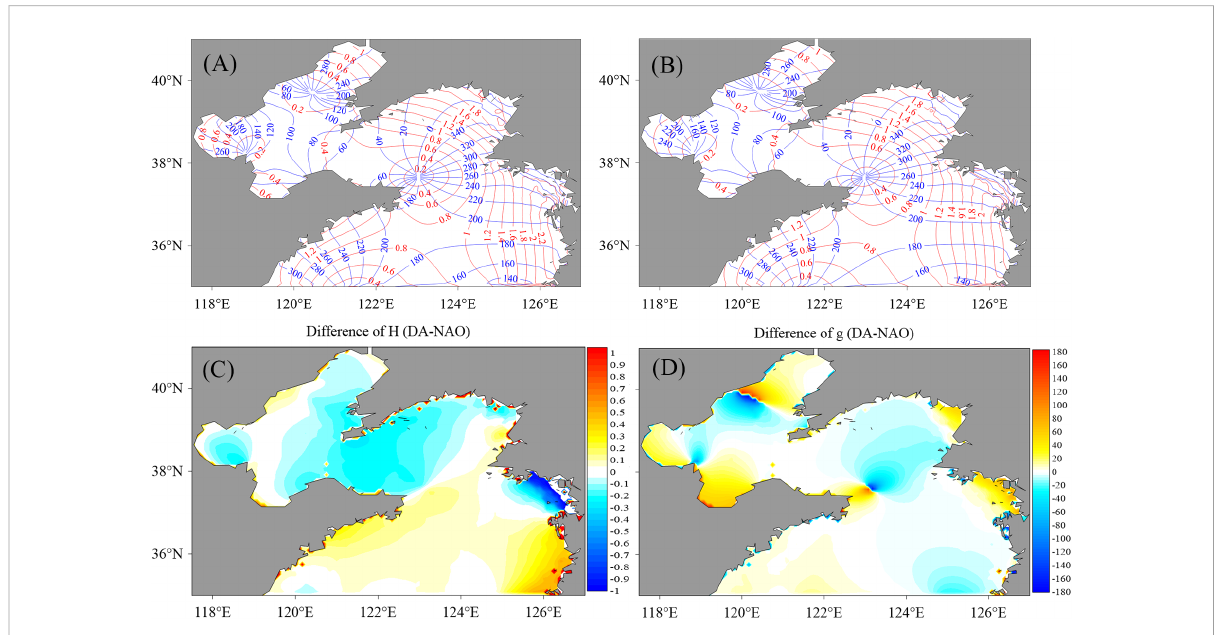
FIGURE 10 The cotidal chart from EXP 6 (A) and EXP 7 (B) and the differences between EXP 6 and NAO for amplitudes (C) and phases (D)